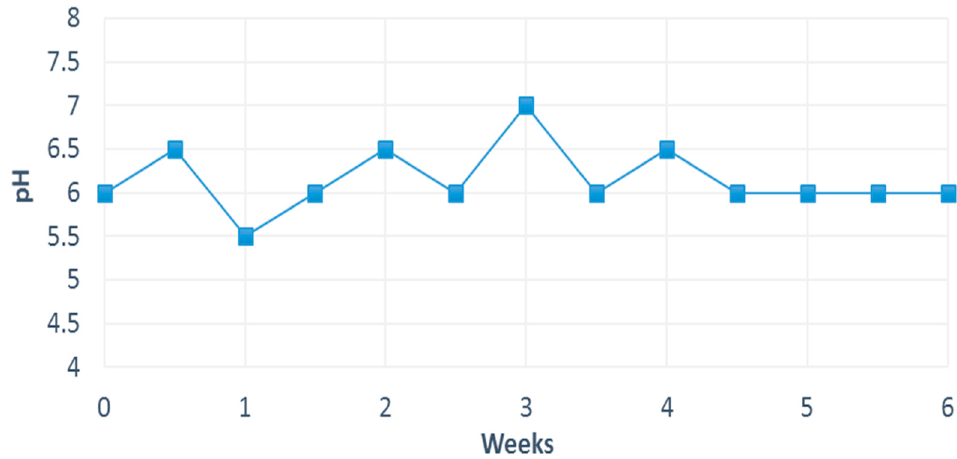
Figure 2. pH behavior of pineapple waste during the pre-composting process.